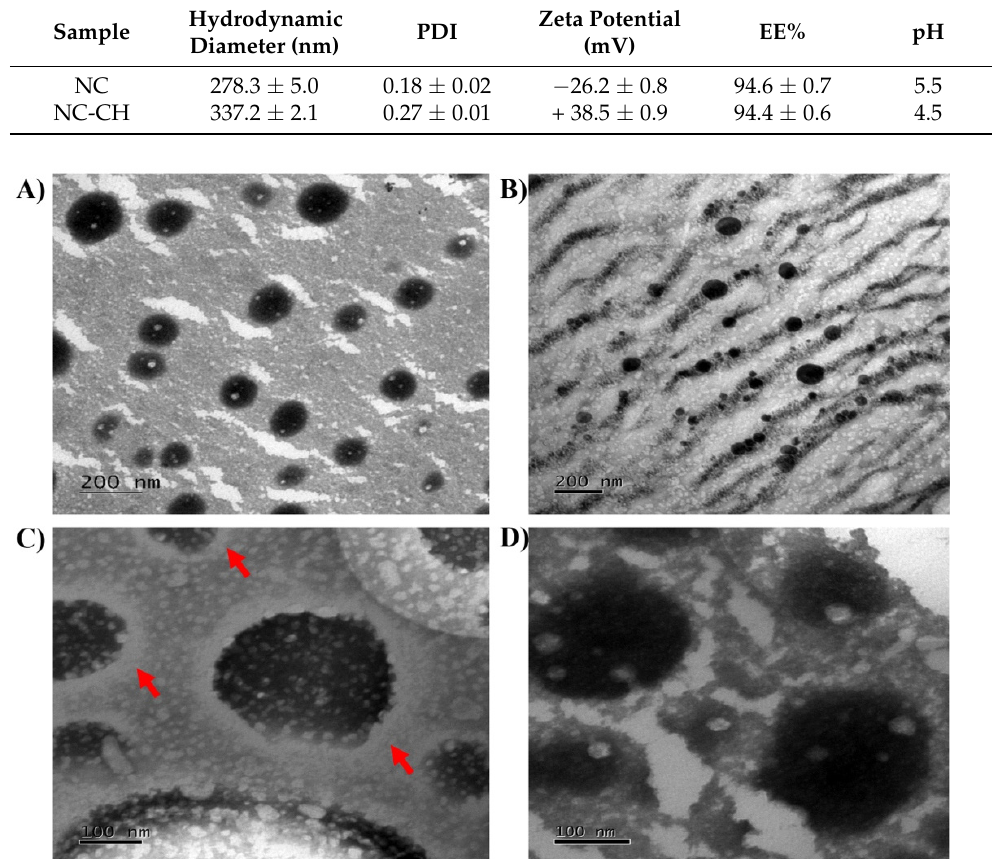
Figure 4. Photomicrographs obtained by TEM. ( A ) Blanc NC (20 K); ( B ) Blanc NC-CH (20 K), ( C ) NC-CH (15 K) and ( D ) NC (15 K). Red arrows represent a “white halo” around the chitosan-coated nanocapsules.